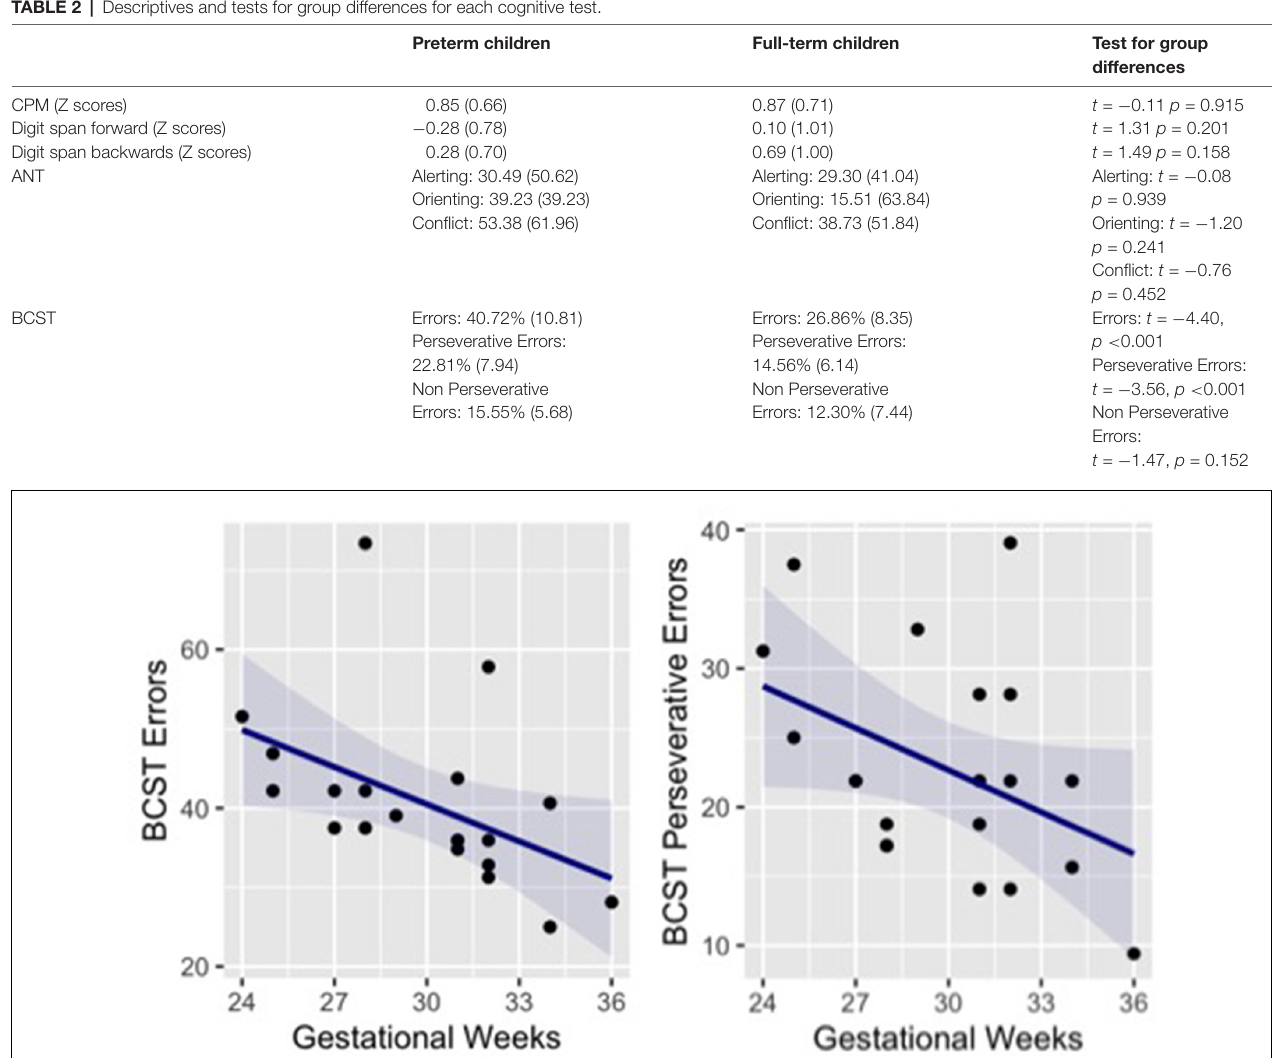
FIGURE 2 | Correlation between preterm children’s gestational age and performance at the BCST (number of errors and number of perseverative errors). BCST, Berg Card Sorting Test.